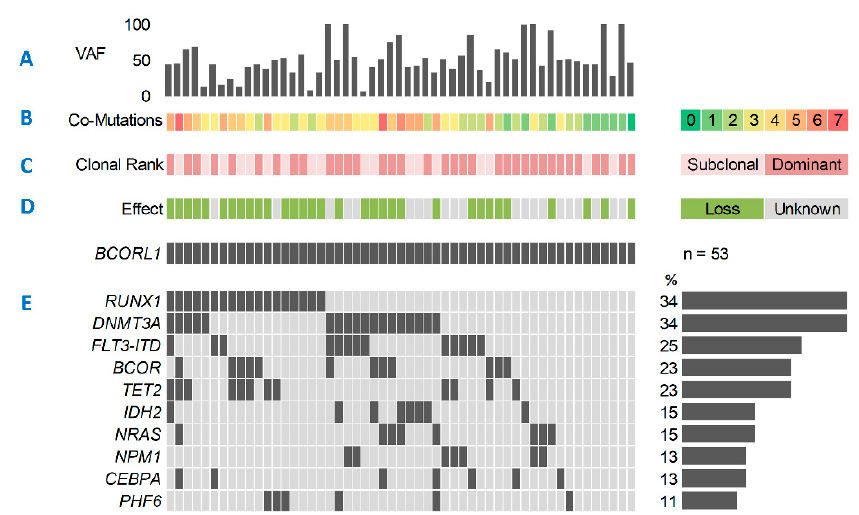
Figure 2. Mutational spectrum of BCORL1 -mutated AML. ( A ) BCORL1 variant allele frequency (VAF)